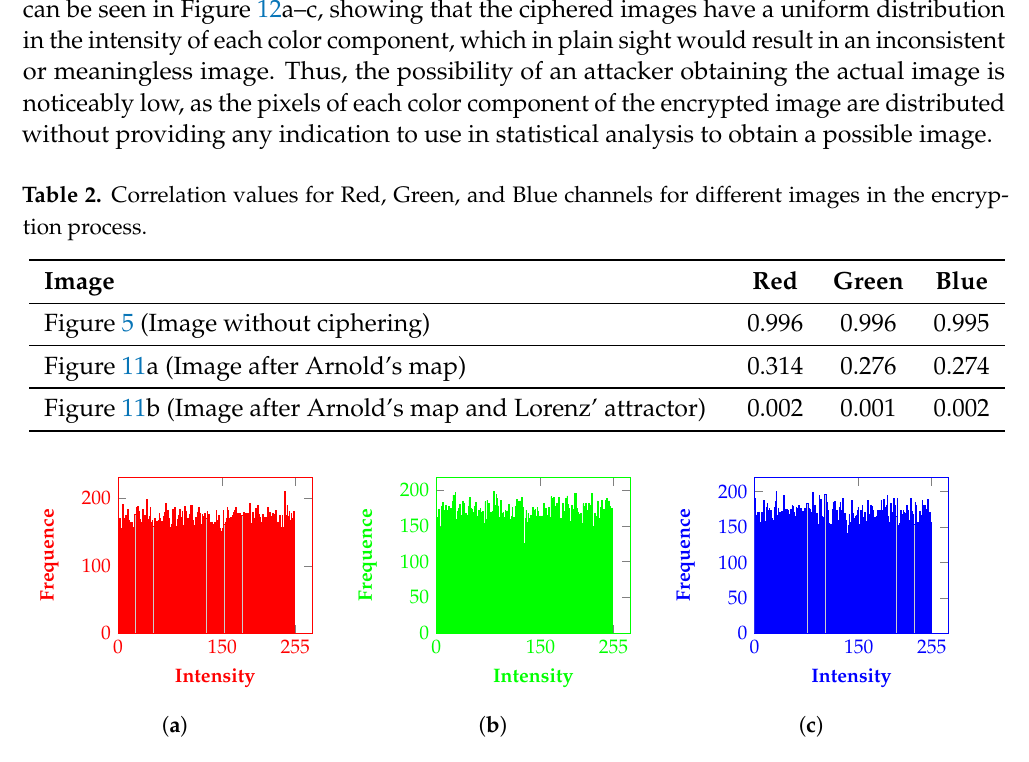
Figure 12. Histograms of RGB channels for a given ciphered image: ( a ) histogram red channel, ( b ) histogram green channel., ( c ) histogram blue